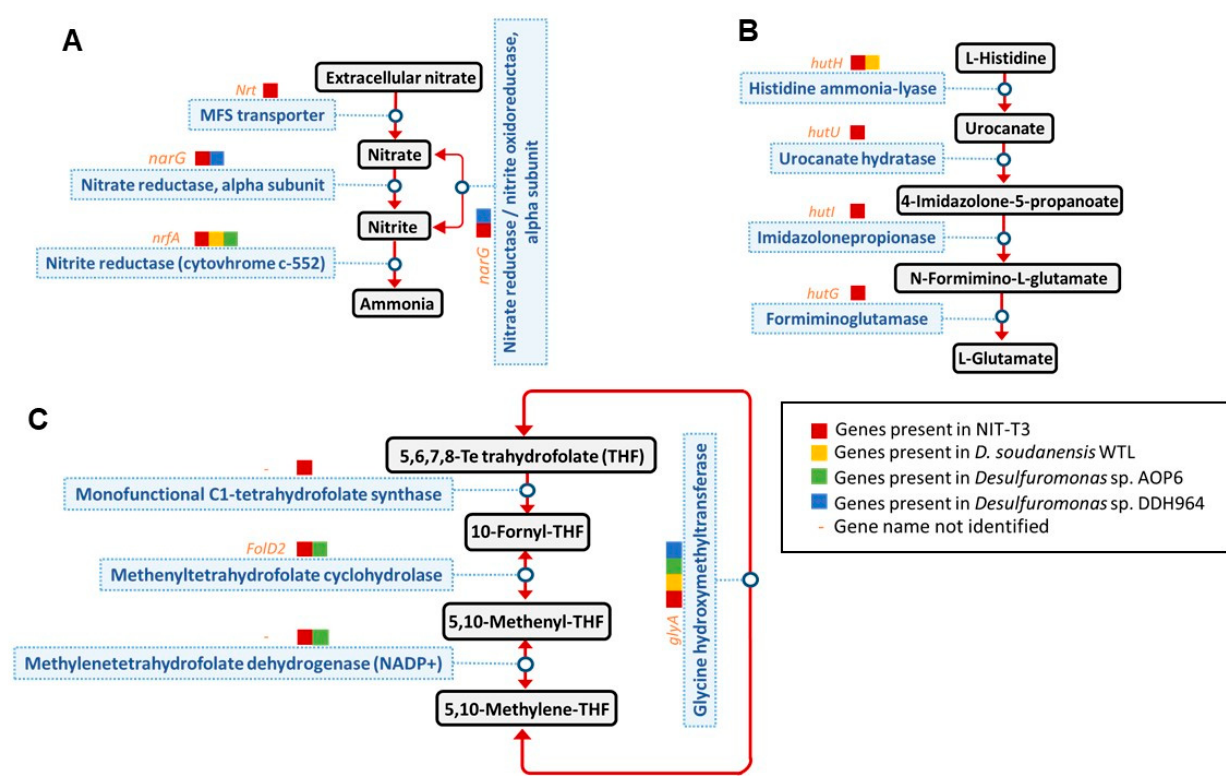
Figure 8. The complete metabolic pathway of strain NIT-T3 distinct from that of the complete genomes of three Desulfuromonas strains . Metabolic pathways of ( A ) nitrate reduction, ( B ) histidine degradation, and ( C ) C1-unit interconversion.